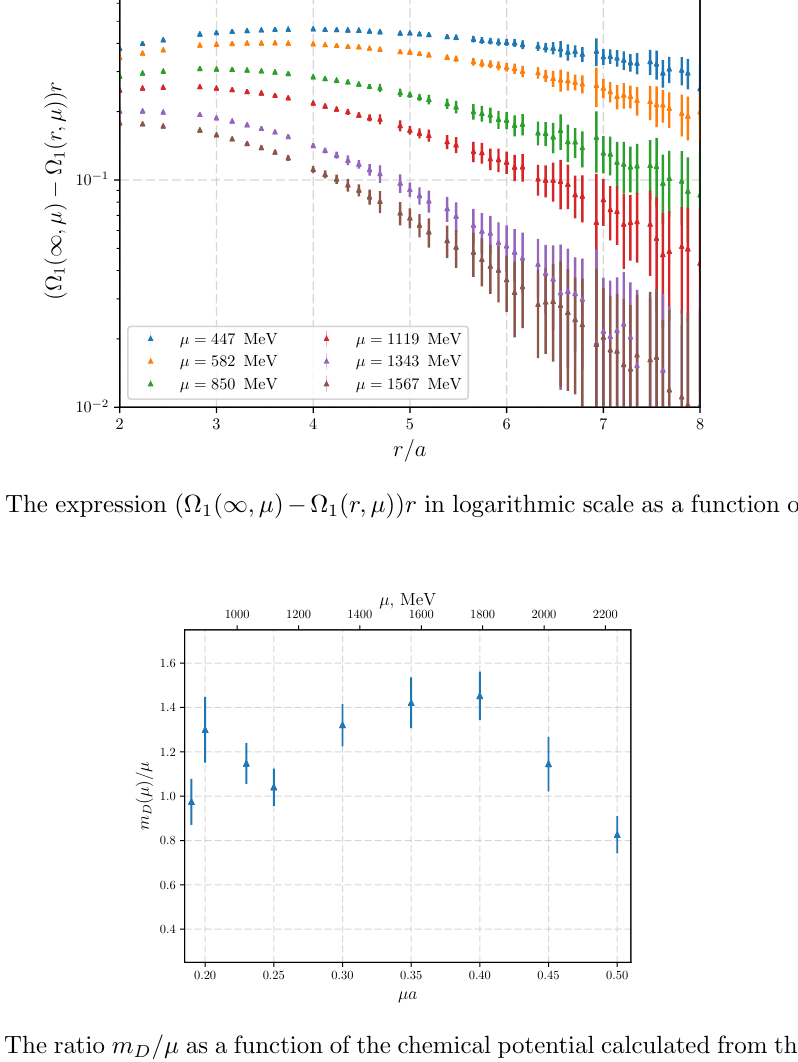
Figure 12 . The ratio m D =(cid:22) as a function of the chemical potential calculated from the (cid:12)t of lattice data by formula